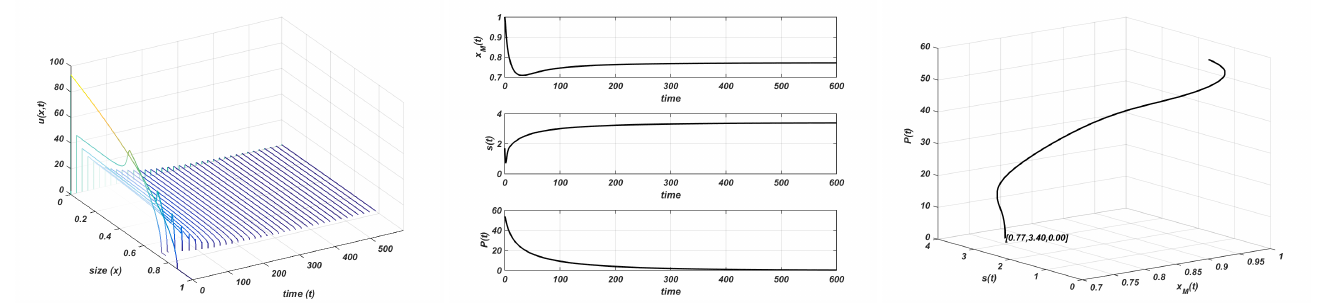
Figure 6. Gompertz growth. r = 3 and K = 3.4. Stable equilibria. Plot on the left : evolution of the structure of the consumer; plot in the centre : evolution of the maximum size, resource, and total consumer population to the equilibrium; plot on the right : orbit followed towards the equilibrium ( 0.77,3.40,0 ) .